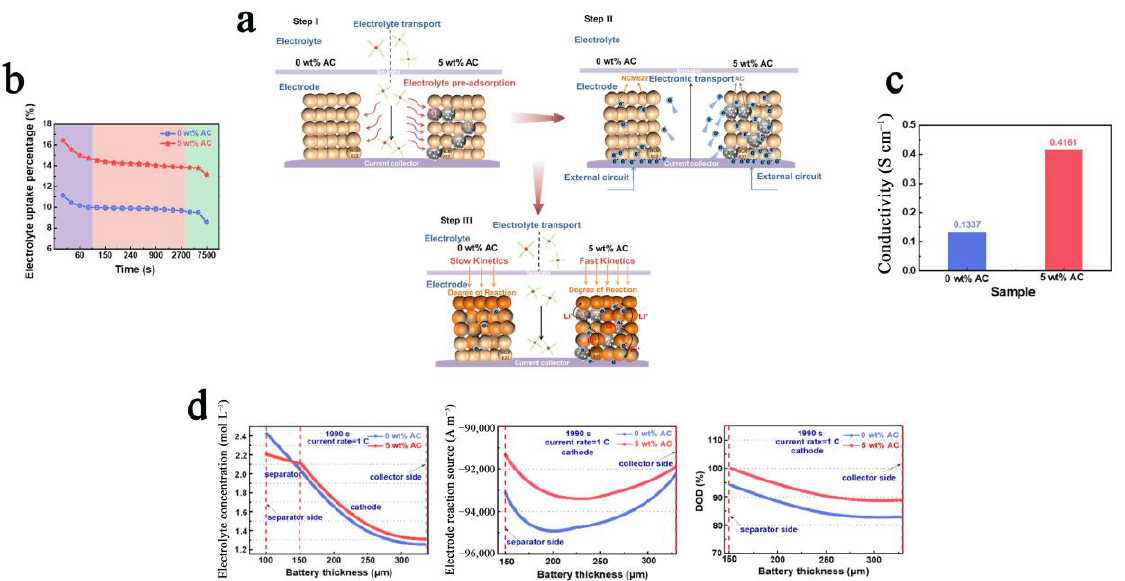
Figure 3. ( a ) Mechanism of AC in promoting charge transfer and accelerating the reaction kinetics; ( b ) Electrolyte uptake percentage; ( c ) Electronic conductivity; ( d ) Simulation results of Comsol [43].